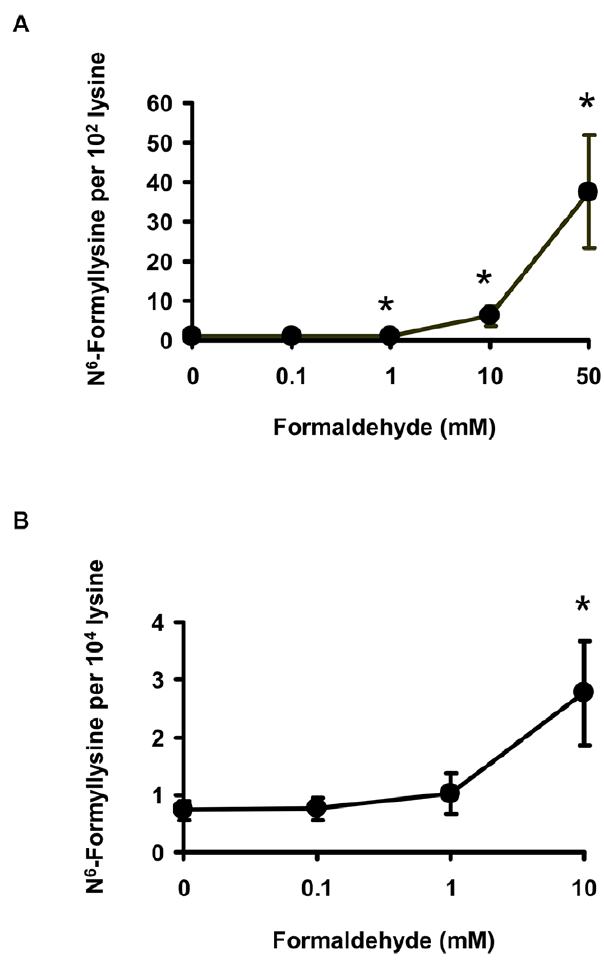
Figure 3. Formaldehyde is a source of N 6 -formyllysine. Formation of N 6 -formyllysine in (A) in vitro reactions of 1 mM L-lysine with formaldehyde for 2 h at 37 u C, and in (B) TK6 cells exposed to formaldehyde, as described in Materials and Methods . Data represent mean 6 SD for N=3, with asterisks denoting statistically significant differences by Student’s t-test (p ,